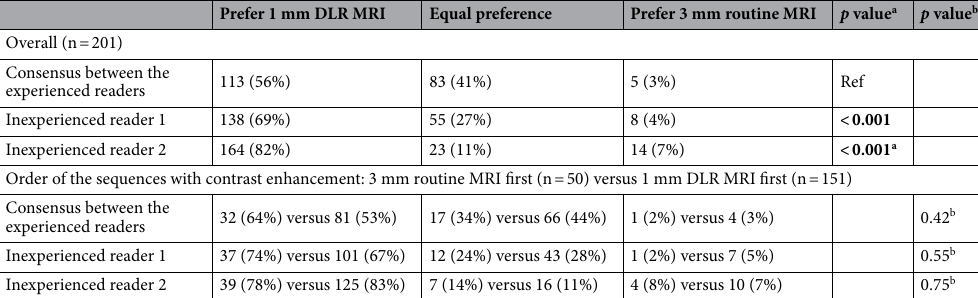
Table 4. Readers’ imaging preference for delineating normal pituitary stalk and gland. Bold values used for emphasizing only values below p value < 0.05. Data are expressed as count with percentage in parentheses. 1 mm DLR MRI = 1 mm slice thickness MRI with deep learning-based reconstruction, 3 mm routine MRI = 3 mm slice thickness MRI. a p value refers to the statistical difference in imaging preference between expert consensus (reference) and each reader. b p value refers to the statistical difference in imaging preference according to the order of the sequences with contrast enhancement.